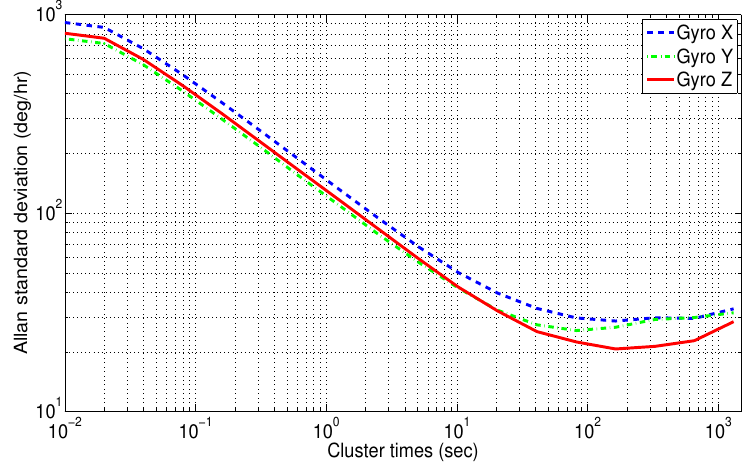
Figure 16. IMU 3DM-GX3-25 Allan variance for three gyro